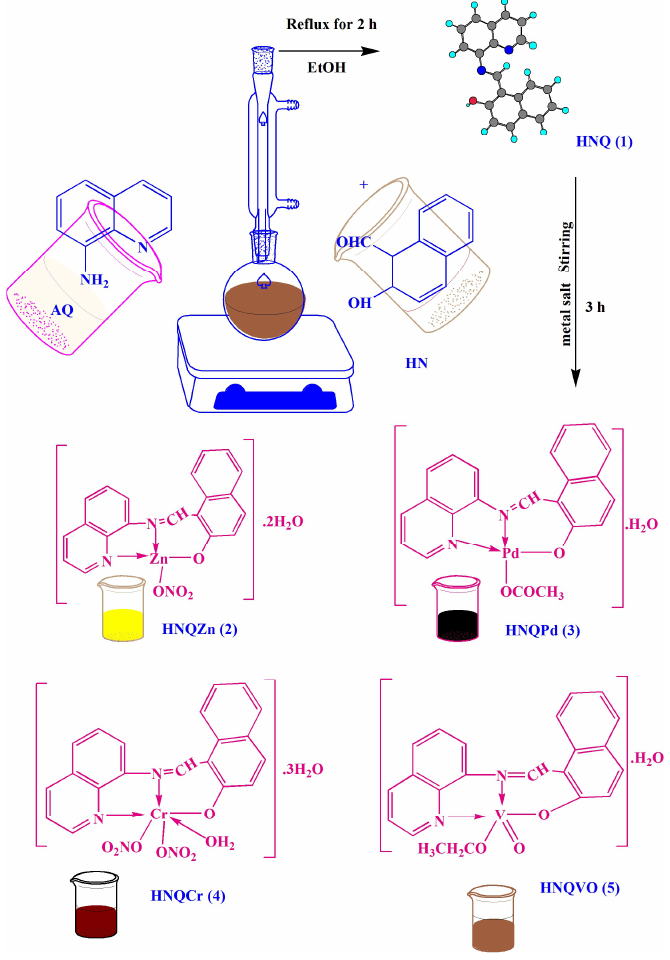
Figure 4. The antioxidant performance of HNQ (1) imine ligand and its Cr(III),VO(II), Zn(II) and Pd(II) complexes (2–5). Reproduced from the permission of ref.